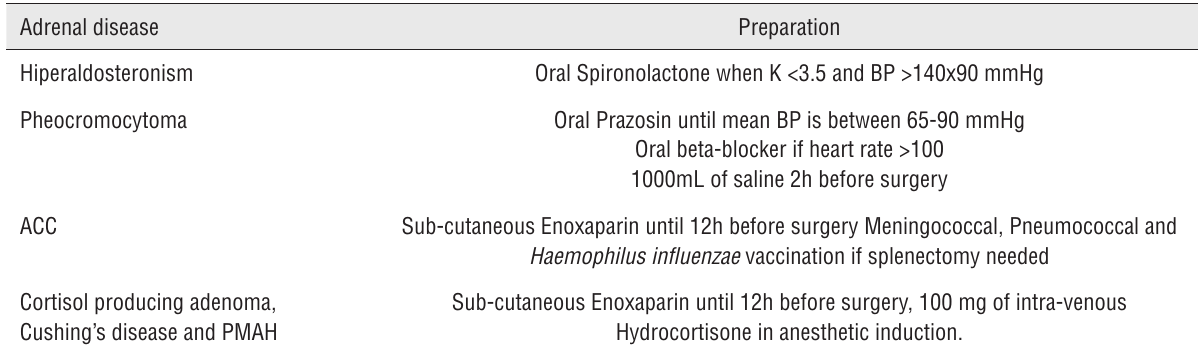
Table 1 – Pre-operative